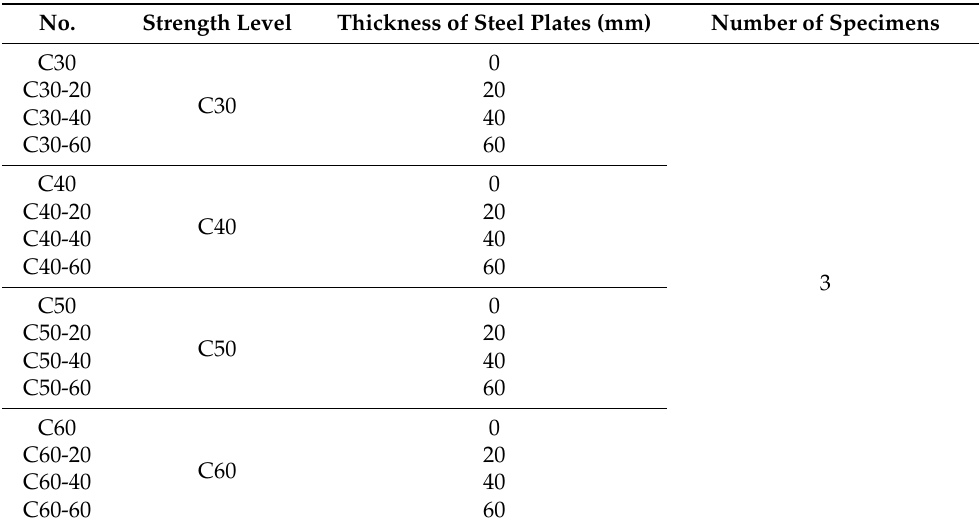
Table 3. List of test